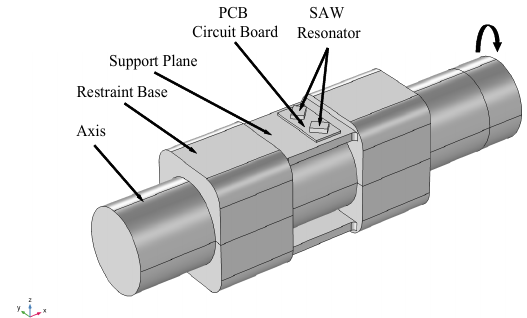
Figure 4. 3D schematic diagram of new SAW torque sensor.